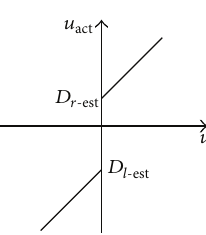
Figure 5: Direct dead-zone inverse